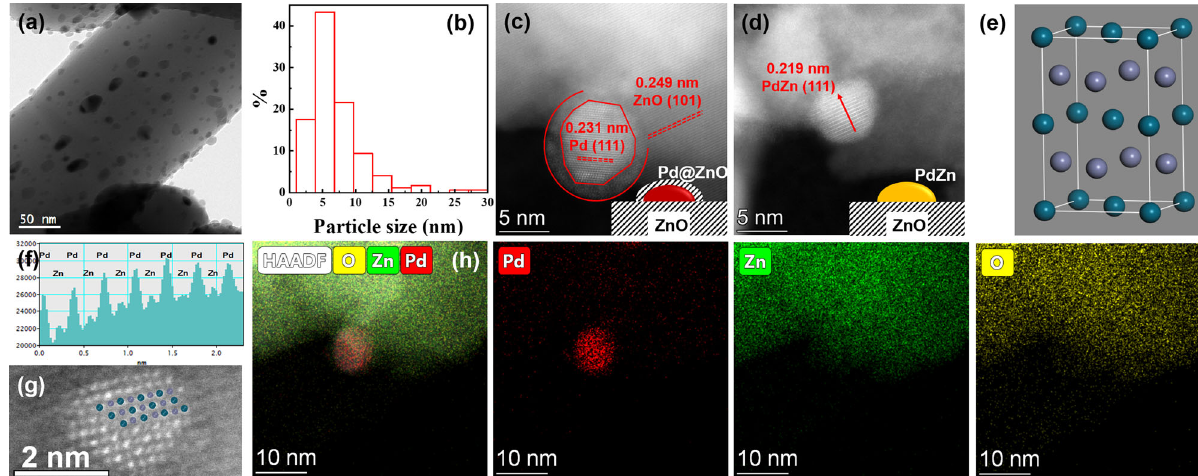
Fig. 2 Morphologies of sample. a TEM image, b the particle size distribution, and c , d HAADF-STEM images with insetting the corresponding models of Pd/ZnO-400 sample. e An atomic model of a unit cell of PdZn (Pd: dark cyan and Zn: indigo blue). f Intensity pro fi le along the arrow in the HAADF-STEM image in d . g The higher magni fi cation HAADF-STEM image of PdZn particles, displaying characteristic ordering of Pd and Zn atoms. h A HAADF-STEM image of Pd/ZnO-400 sample along with the corresponding EDS elemental maps of Pd, Zn, and